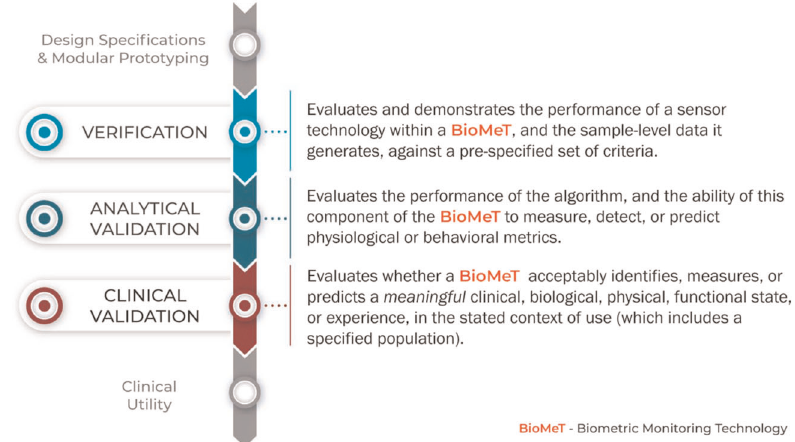
Fig. 1 The stages of V3 for a BioMeT: Veri fi cation, analytical validation, and clinical validation of BioMeTs is a multi-step process. The stages of V3 for a